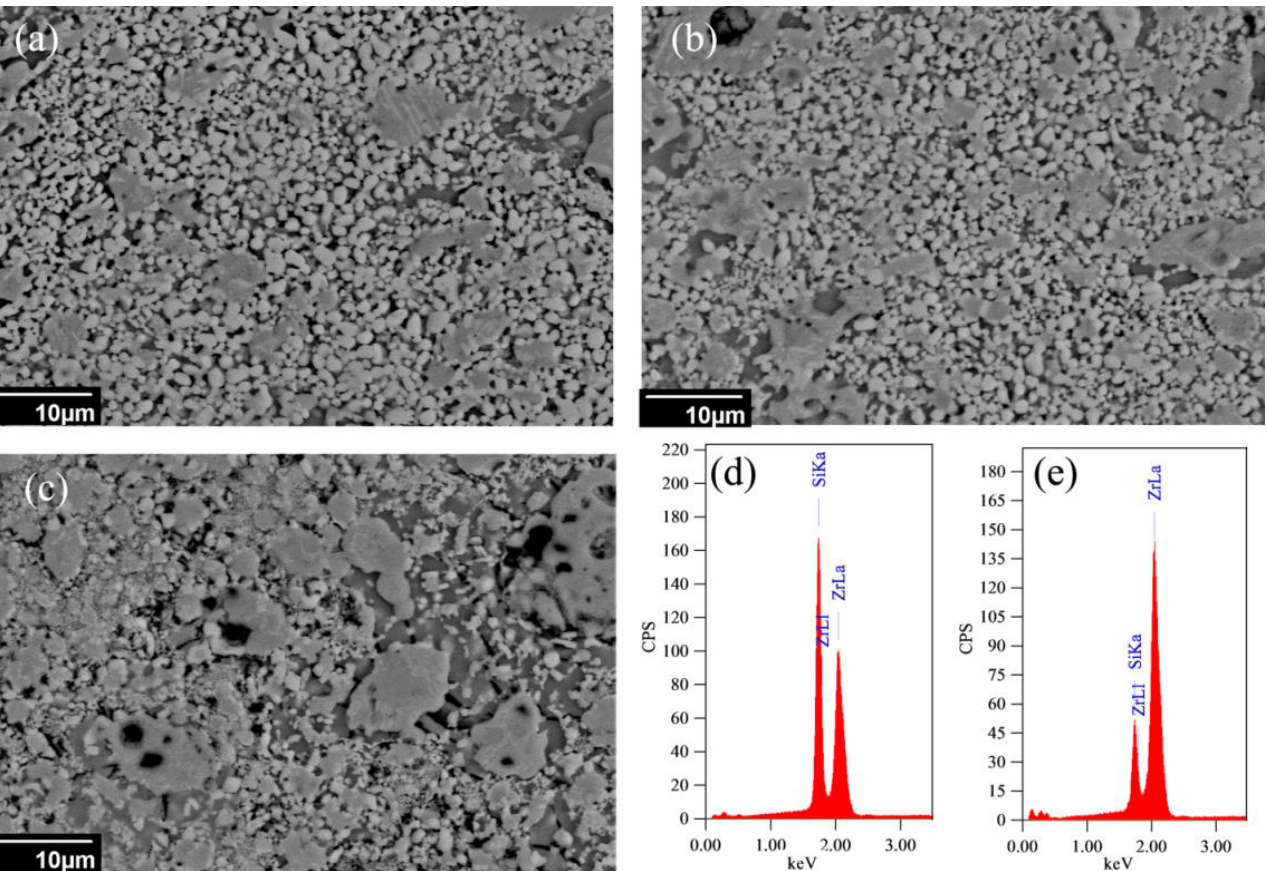
Figure 6. BSE image of ZrN/ZrSi 2 reinforced with different ZrO 2 wt% prepared at 234 MPa: ( a ) 10 wt% ( b ) 20 wt% ( c ) 30 wt% ( d ) EDX of dark gray area (sample-b) ( e ) EDX of light gray areas (sample-b).